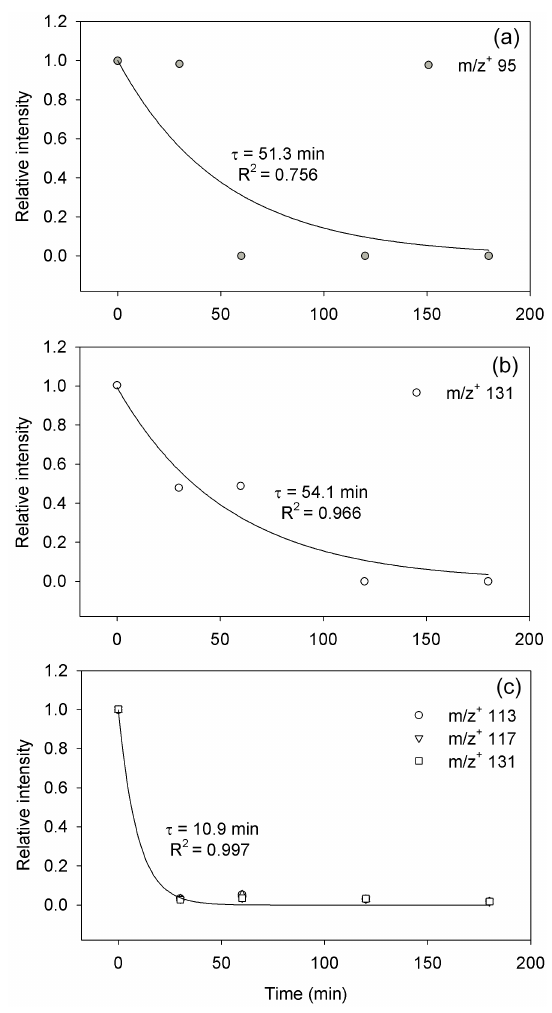
Figure 3. The decay of glyoxal in SA aerosols in the humid (a) and in the dry chamber (b) , and in AS aerosols in the dry chamber (c) ( τ = lifetime).